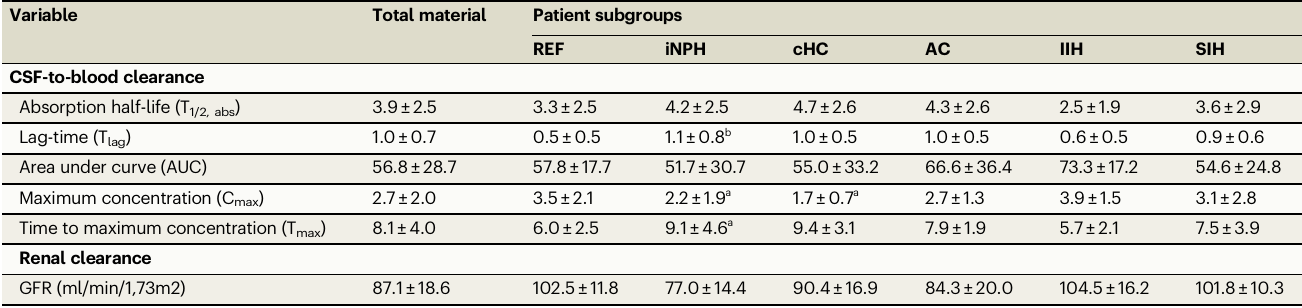
Table 2 | CSF-to-blood clearance variables for the entire cohort and the different patient categories